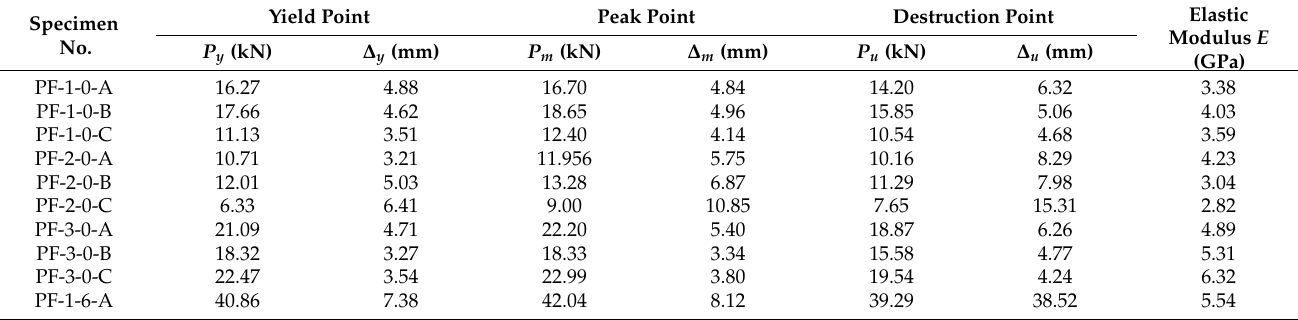
Table 6. Feature point